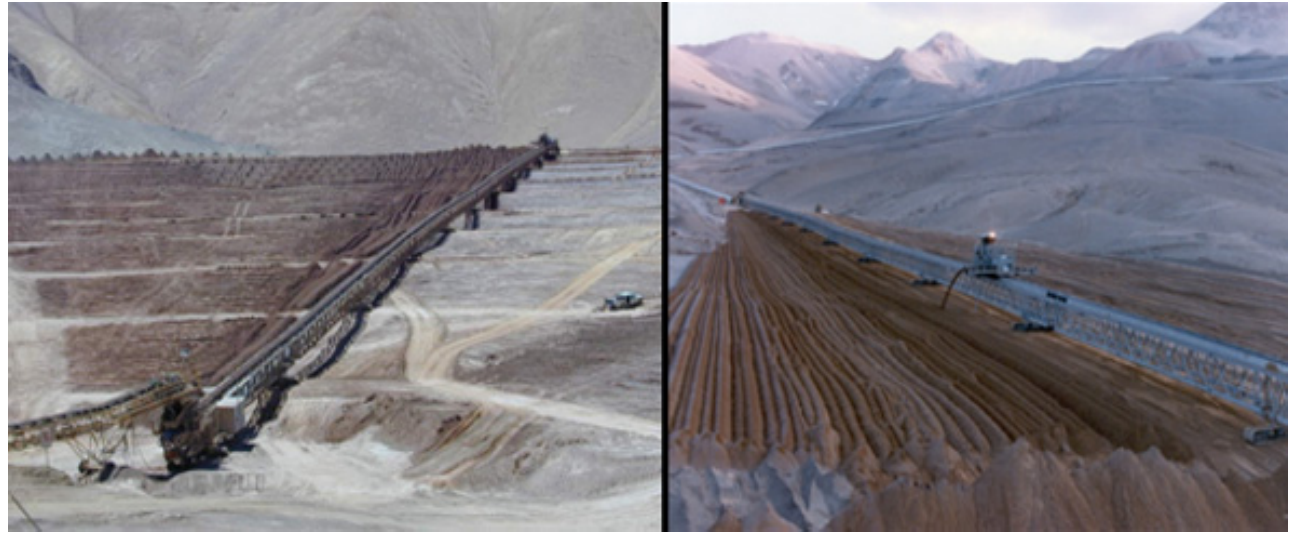
Figure 19. La Coipa Mobile Stacking Conveyor (MSC) at Rako TSF [24,58].